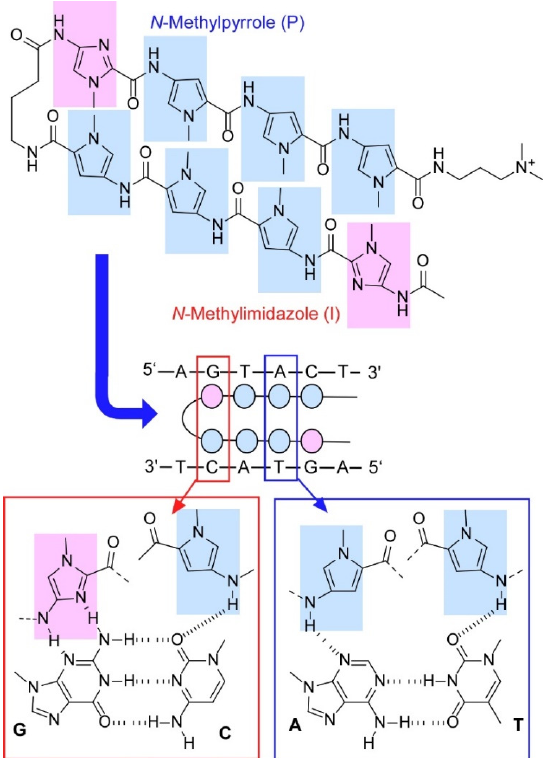
Figure 22. A polyamide with N -methylpyrrole ( P ) and N -methylimidazole ( I ) with bending hairpin structure binds to the minor groove of DNA upon hydrogen bond formation to specific nucleobases.